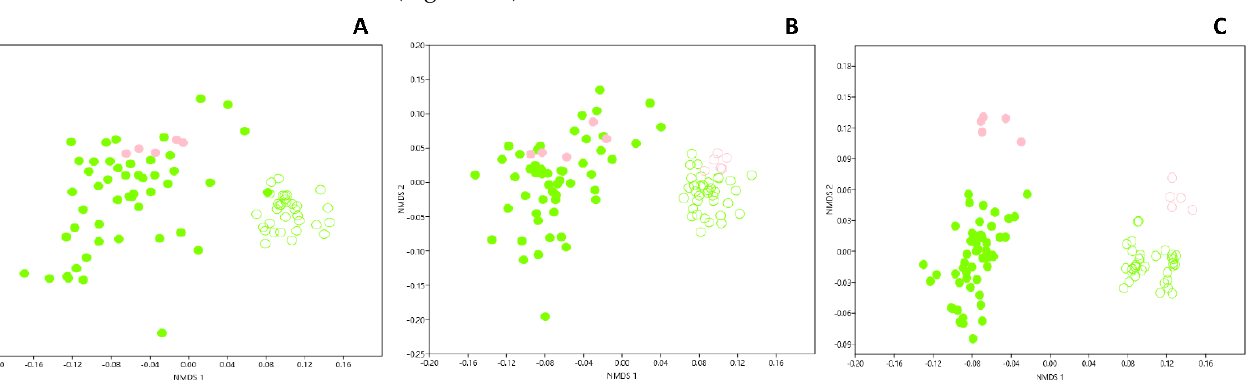
Figure 6. NMDS comparison of dark zones and nearby unstained parts from the walls of Lascaux’s in February 2017, based on the relative proportion of both phyla and classes in the fungal ( A ), micro-eukaryotic ( B ) and bacterial communities ( C ). Apse data for dark zones and their neighboring unstained parts are those already shown in Figure 2 for the same sampling dates. Stress values were 0.19, 0.19 and 0.15 for fungi, micro-eukaryotes and bacteria, respectively. Green circles represent Apse samples, pink circles Nave samples, and empty symbols unstained parts of the Apse and Nave.